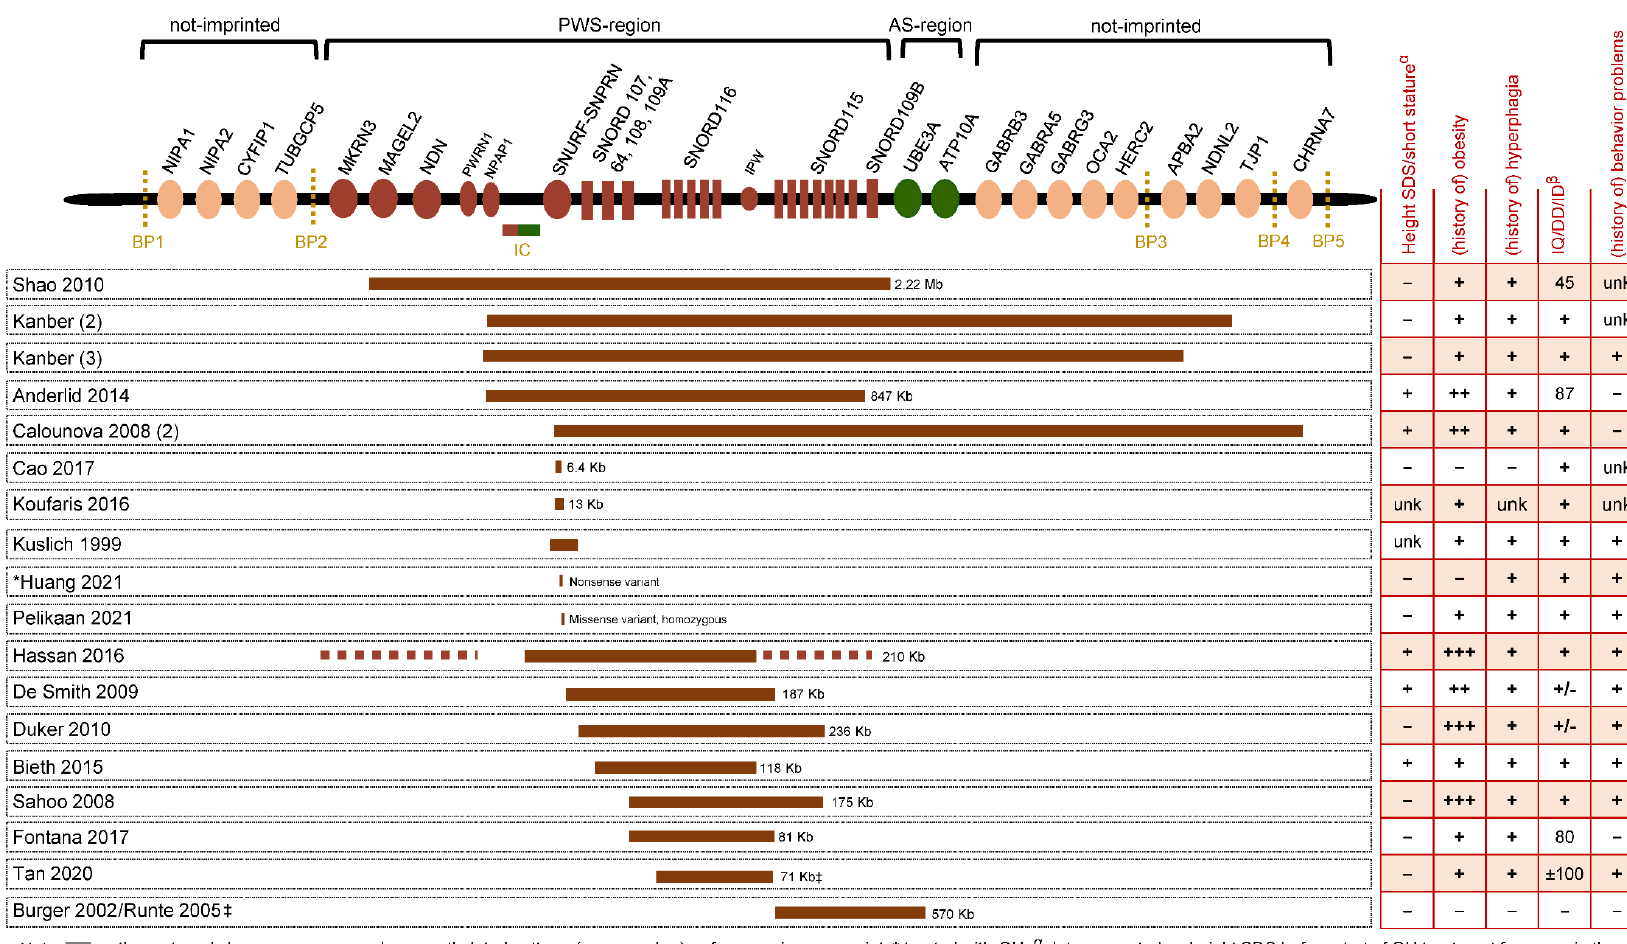
Figure 1. Size of the deletion and location per patient